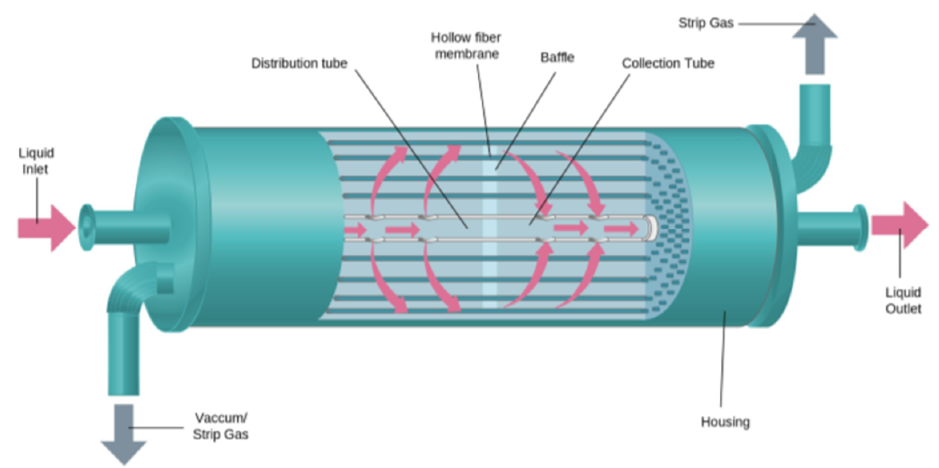
Figure 1. A schematic diagram of Hollow Fiber membrane contactor (adapted from Liqui-Cel ® manual) [34].